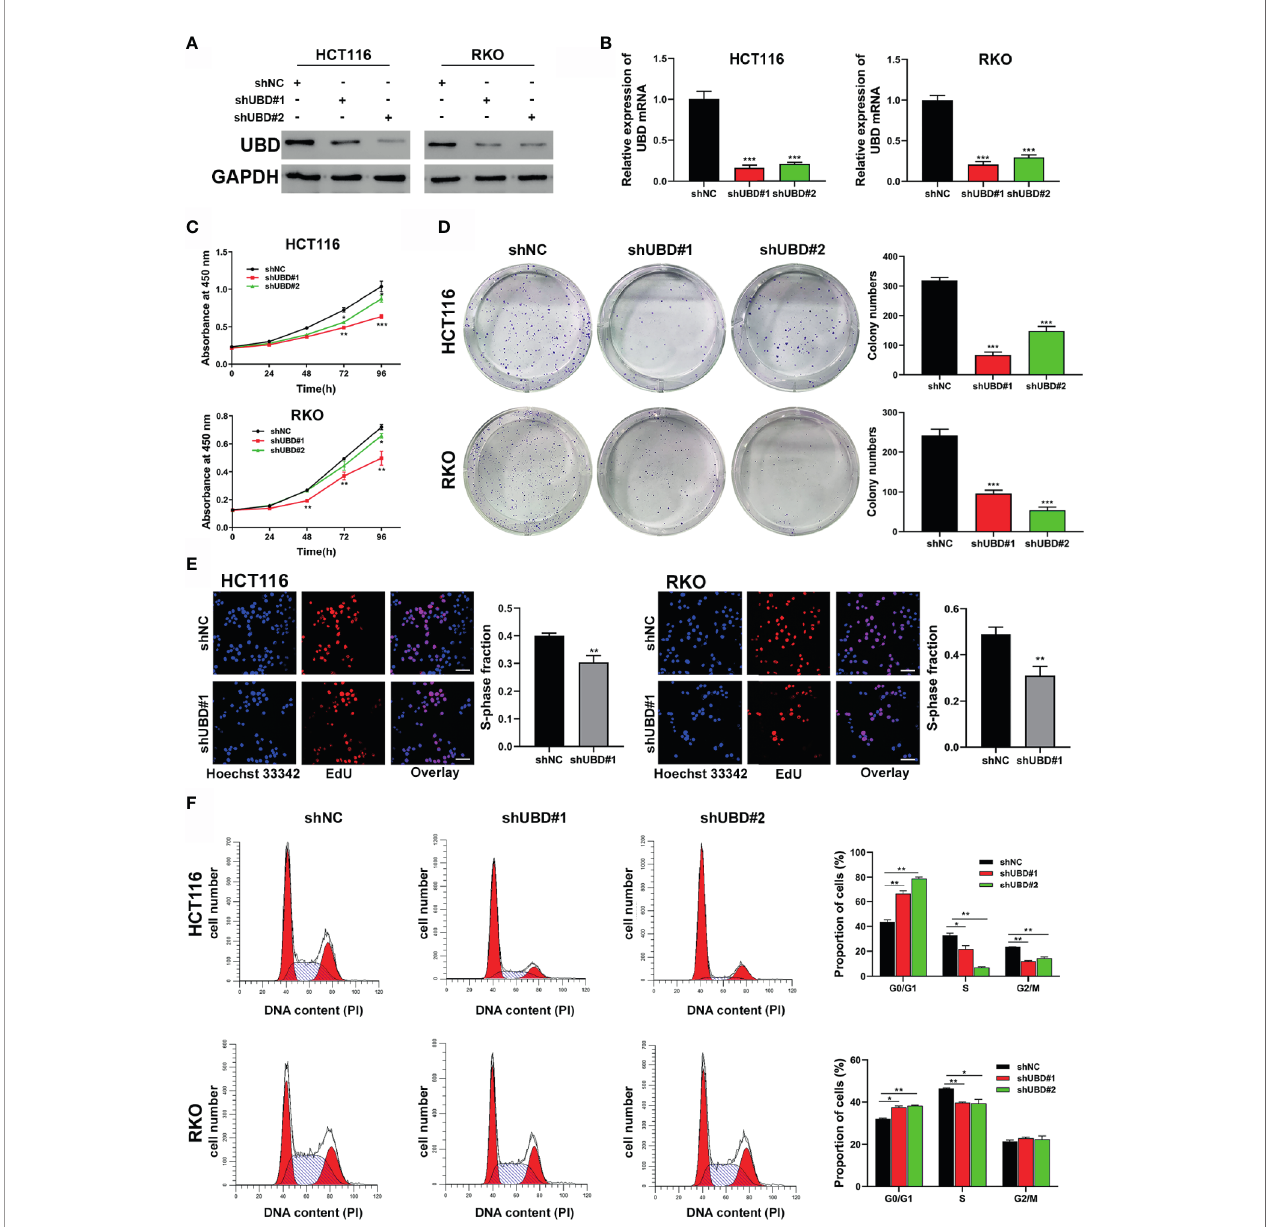
FIGURE 2 | Knockdown of UBD inhibits the CRC cell growth and cycle progression in vitro . (A, B) Knockdown ef fi ciency of UBD in HCT116 and RKO cells detected using Western blotting (A) and qRT-PCR (B) (*** p < 0.001). GAPDH was used as an endogenous control. (C) CCK-8 assay was used to analyze the cell viability of UBD stable knocked down HCT116 and RKO cells (* p < 0.05; ** p < 0.01; *** p < 0.001). (D, E) The effect of UBD downregulating on the proliferation of HCT116 and RKO cells compared with negative control were analyzed by colony formation assays (D) and EdU assay (E) , magni fi cation, 400×; scale bar, 100 m m). Quantitative results of colony numbers and EdU positive cells are presented in data graphs (** p < 0.01; *** p < 0.001). (F) Flow cytometry assays were performed to analyze cell cycle in HCT116 and RKO UBD stable knockdown cell lines (* p < 0.05; ** p < 0.01). shNC, short hairpin negative control; CCK-8, Cell Counting Kit-8; EdU, 5-ethynyl-2 ’